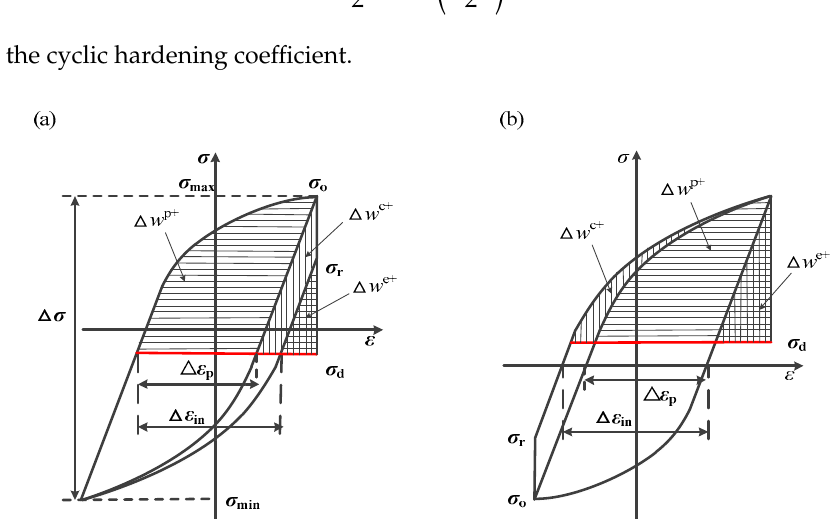
Figure 1. Schematic illustration of total tensile strain energy density in different loading waveforms .